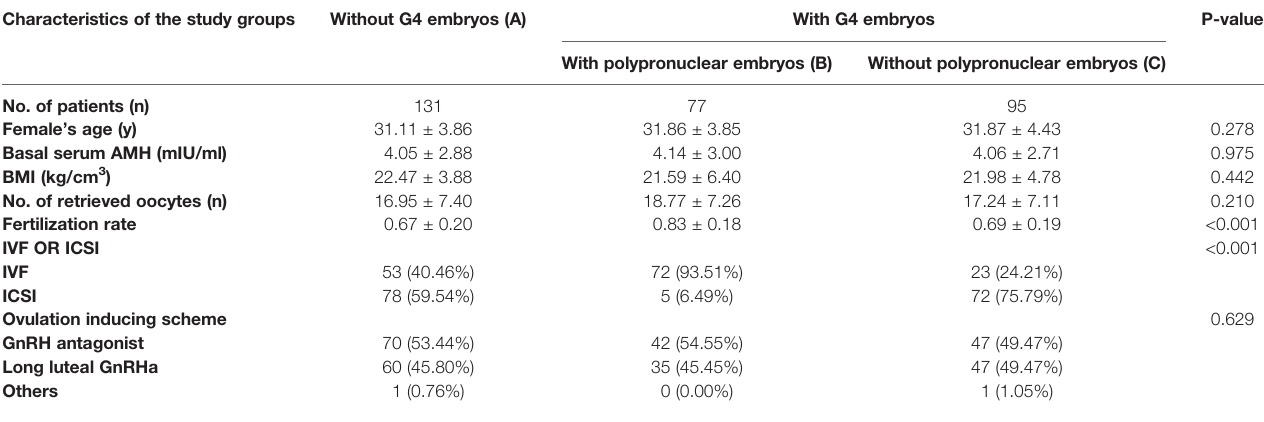
TABLE 1 | Baseline characteristics of selected participants. Characteristics of the study